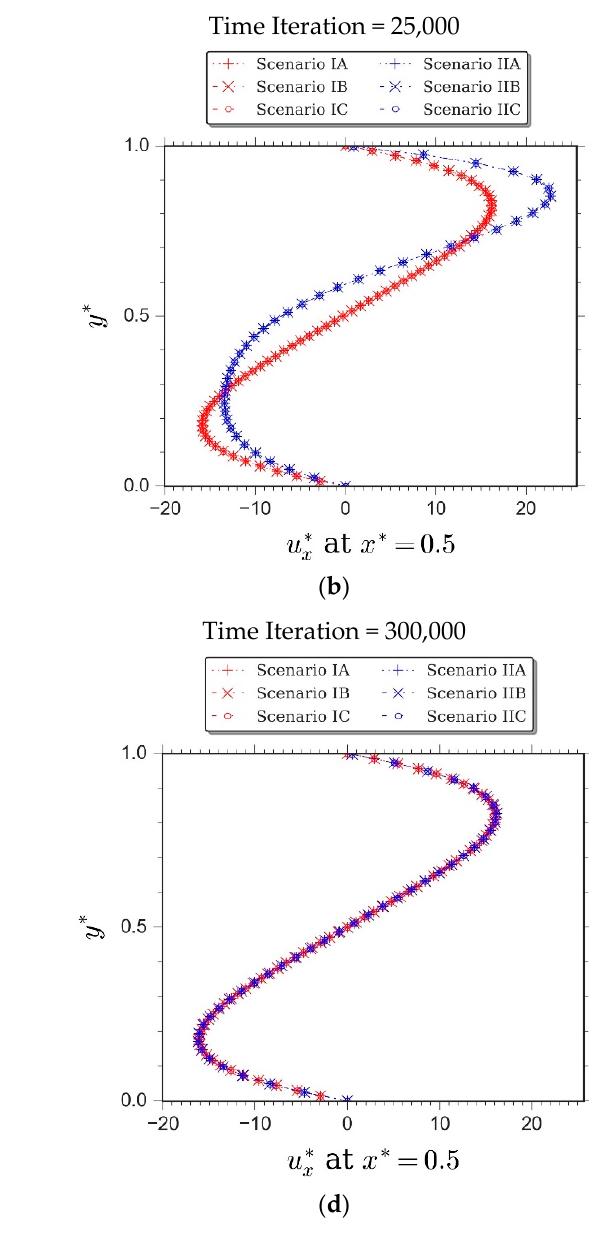
Figure 4. Profiles of dimensionless horizontal velocity at the vertical mid-plane of the cavity upon different simulation periods of natural convection in differentially-heated cavity for Ra = 10 4 , Pr = 0.71, τ υ = 0.6 and Ma = 0.1, demonstrating condition at time iteration: ( a ) 10,000; ( b ) 25,000; ( c ) 50,000 and ( d ) 300,000.